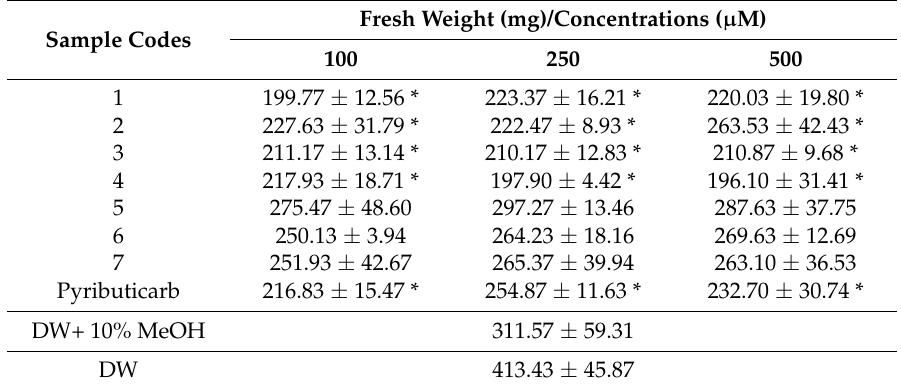
Table 7. Effect of isolated compounds from rice ( O. sativa ) on fresh weight of E. oryzicola after 7 days.